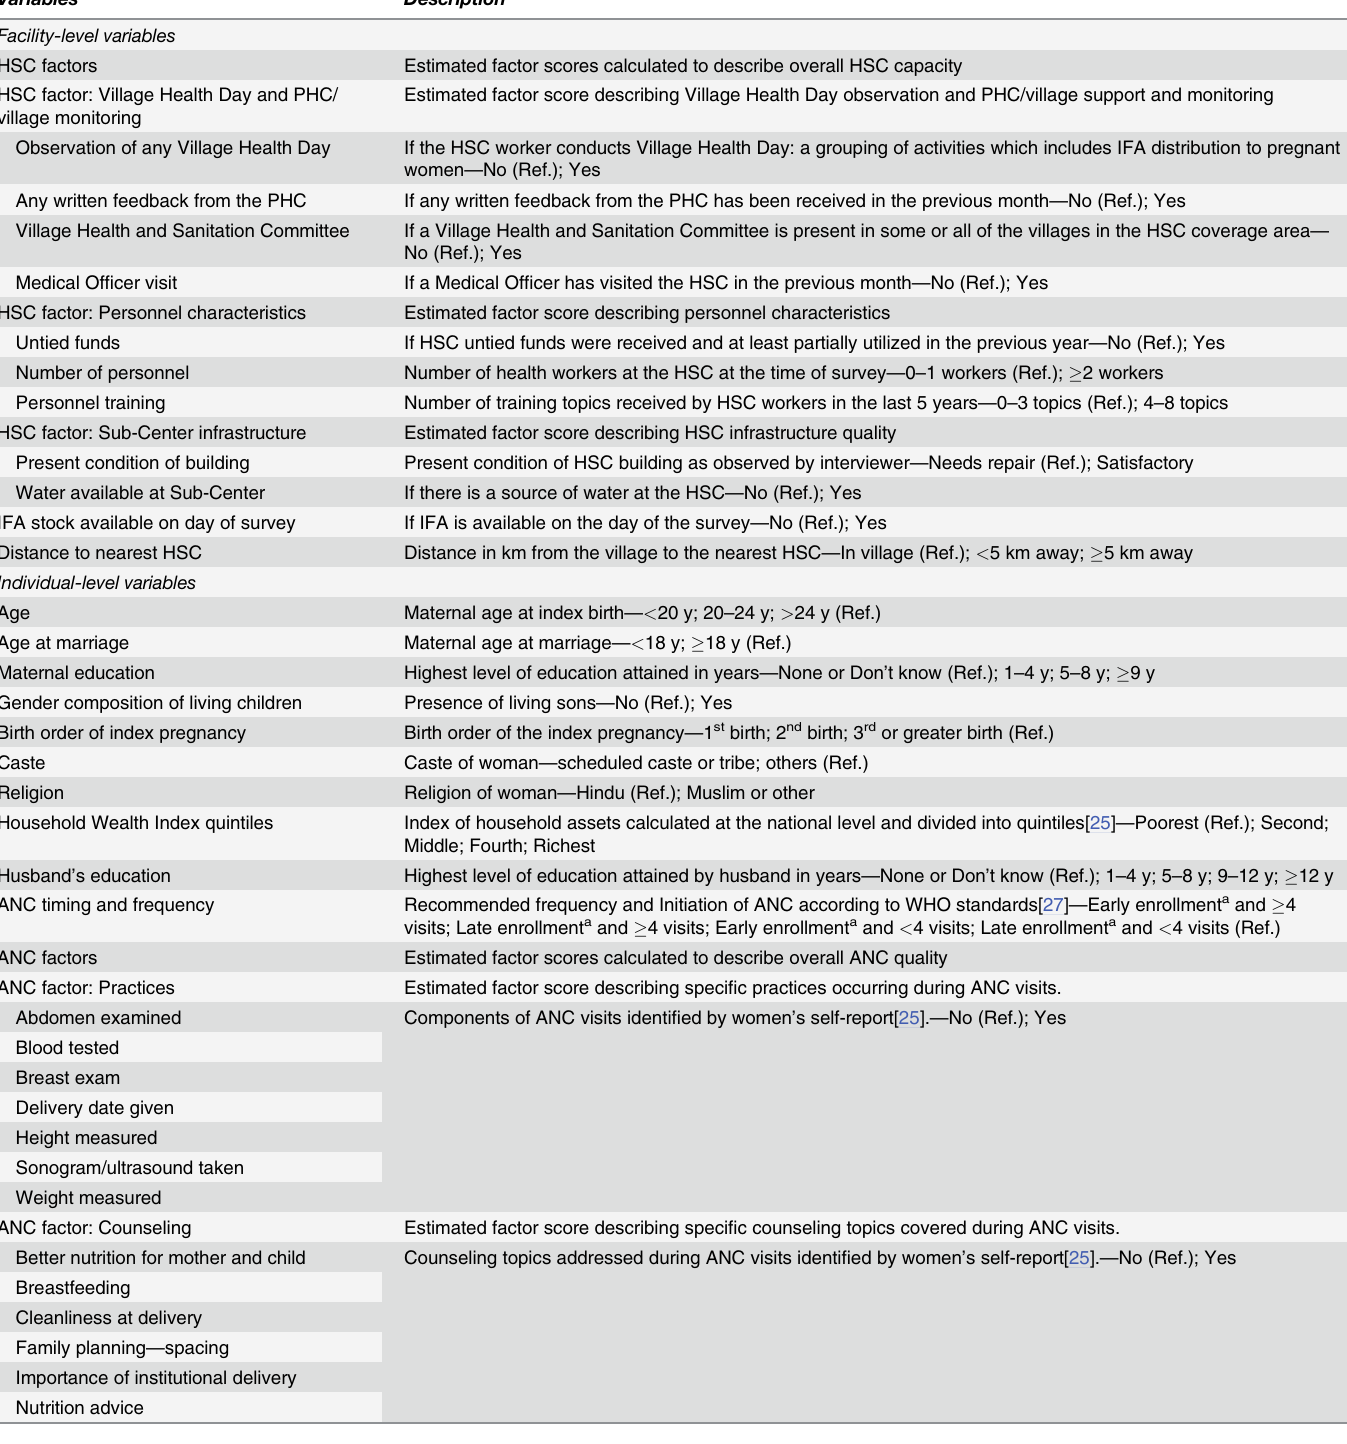
Table 3. Variable definitions included in multilevel modeling of IFA receipt and